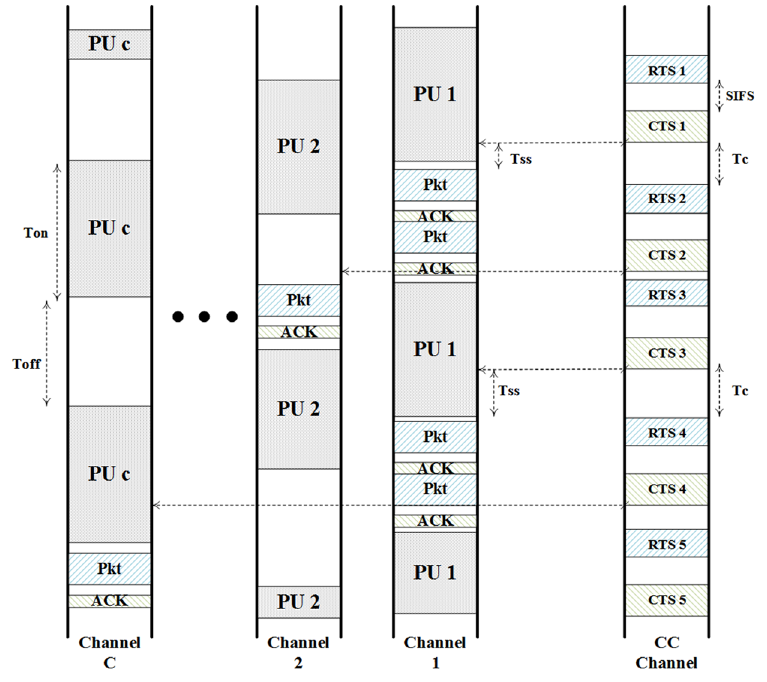
Fig 2. Spectrum access driven by the CSMA/CA-based common control channel.